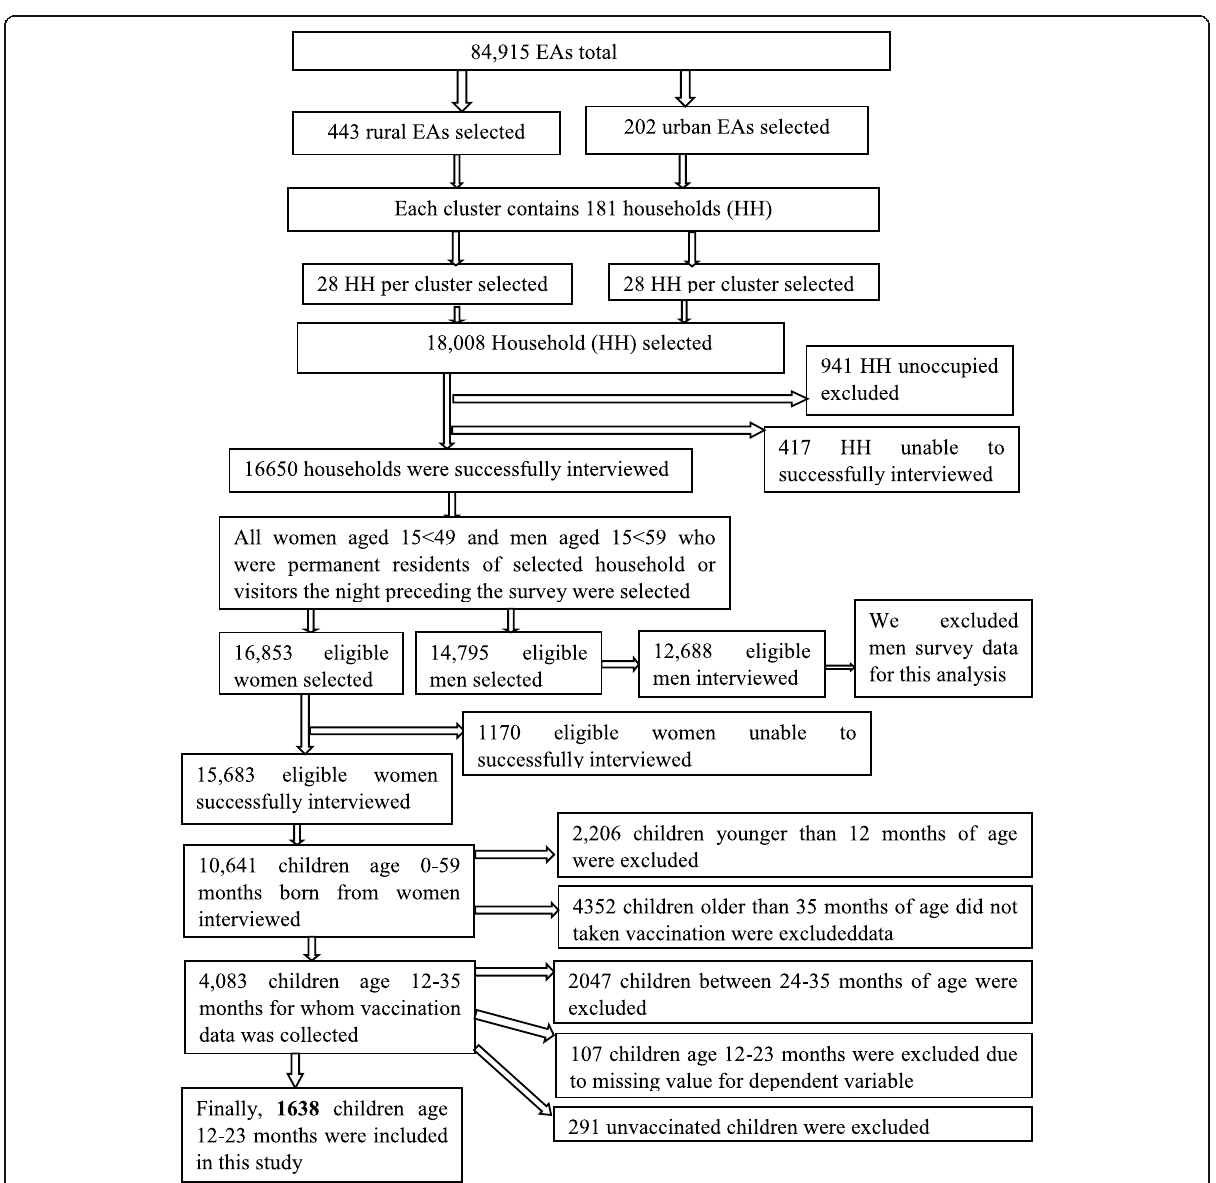
Fig. 1 Sampling procedure extracted for children aged from 12 to 23 months from Ethiopian Demographic Health Survey